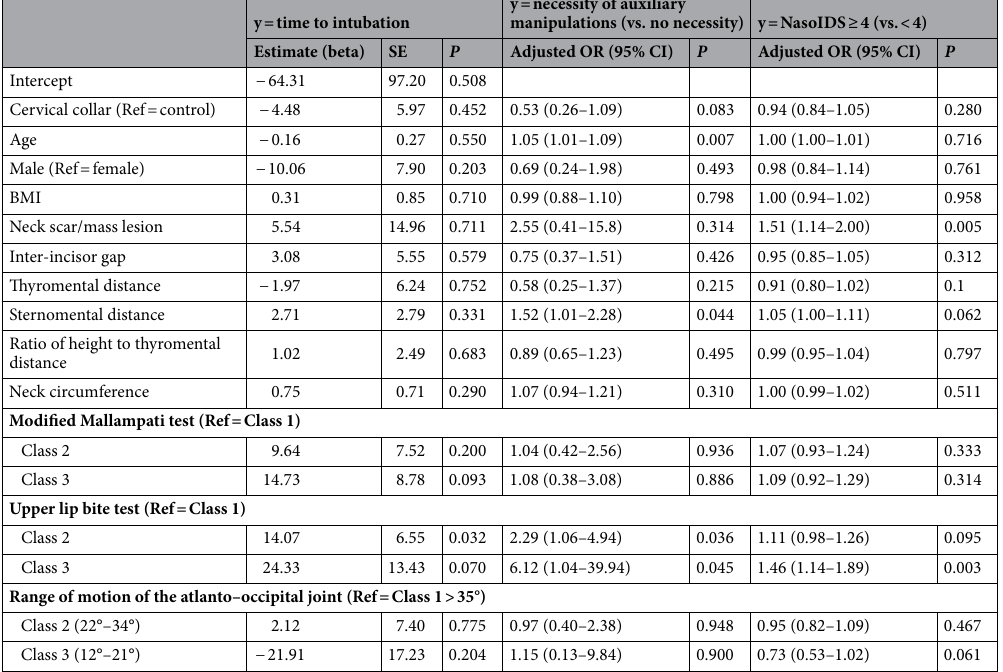
Table 3. Summary of multivariate analysis with generalized estimating equation modeling for variables associated with (1) time to intubation, (2) the necessity of auxiliary manipulations, and (3) nasoIDS ≥ 4 during NTI. nasoIDS nasotracheal intubation difficulty